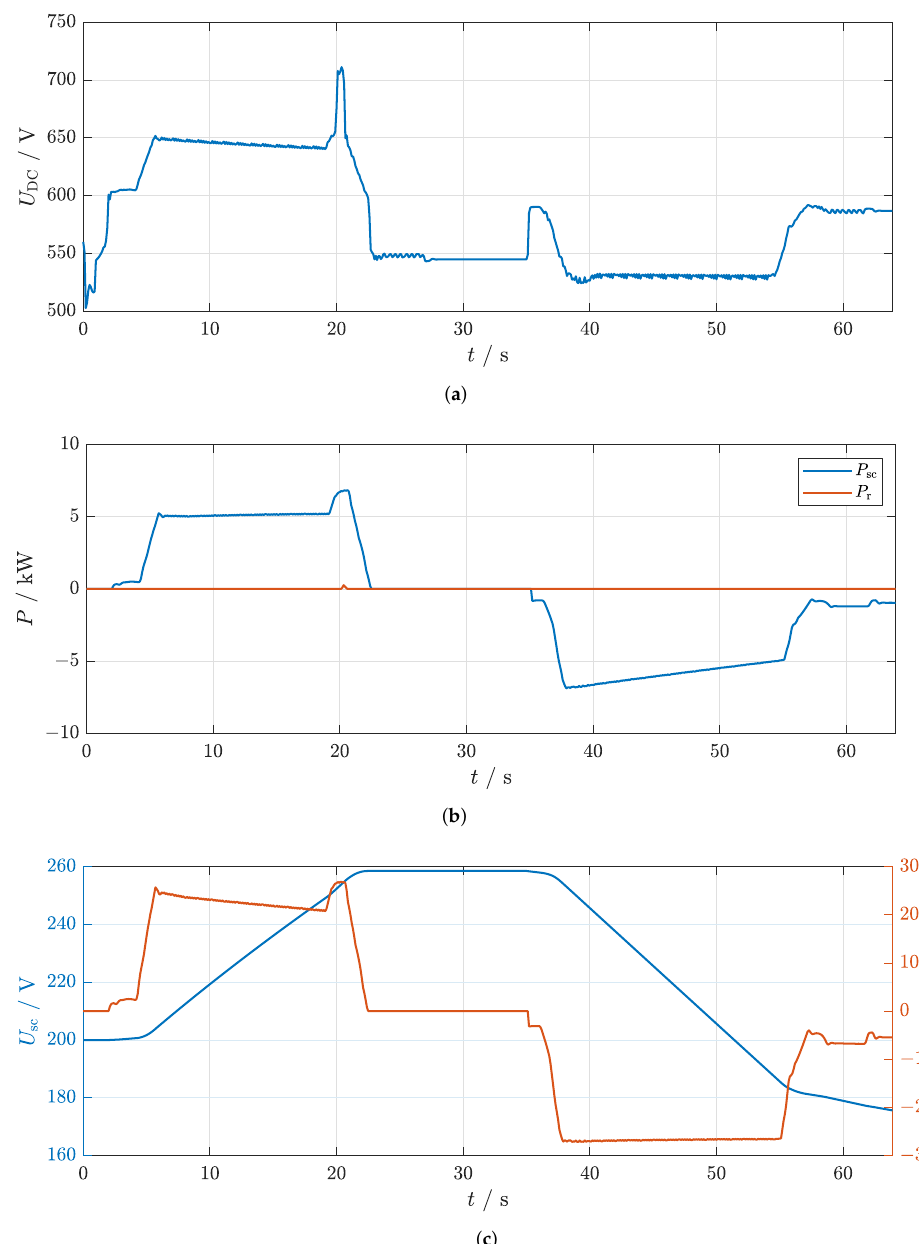
Figure 12. Simulation results for the reference cycle. ( a ) DC bus voltage. ( b ) SC bank power and braking resistor power. ( c ) Voltage and current of the SC